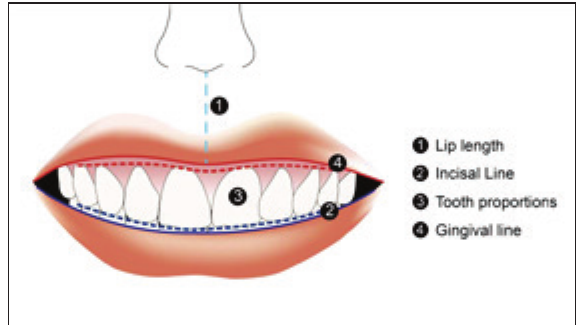
Figure 2. The LIPG principle is recommended for intraoral step-by-step analysis of a gummy smile. Lip lengths at rest and during full smile are measured first to determine whether the upper lip is short or hyperactive. Secondly, an incisal line is determined based on the curvature of the lower lip and the amount of tooth displayed at rest. Third, each tooth length is decided by the average figures provided in the literature. Finally, the gingival level of each tooth can subsequently be decided after consideration of the relationship of the position of the incisal edge and tooth length. In general, the gingival level is parallel to the inferior border of the upper lip.